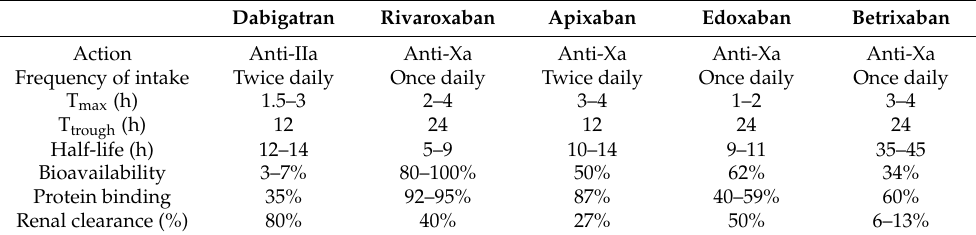
Table 1. Comparative pharmacology of direct oral anticoagulants (DOACs).